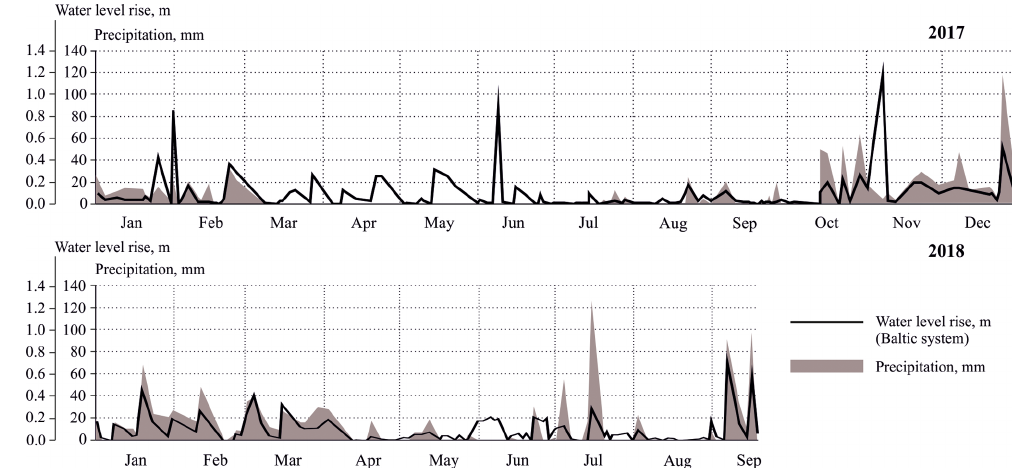
Figure 5. Water level (1) and precipitation (2) changes during the monitoring period.